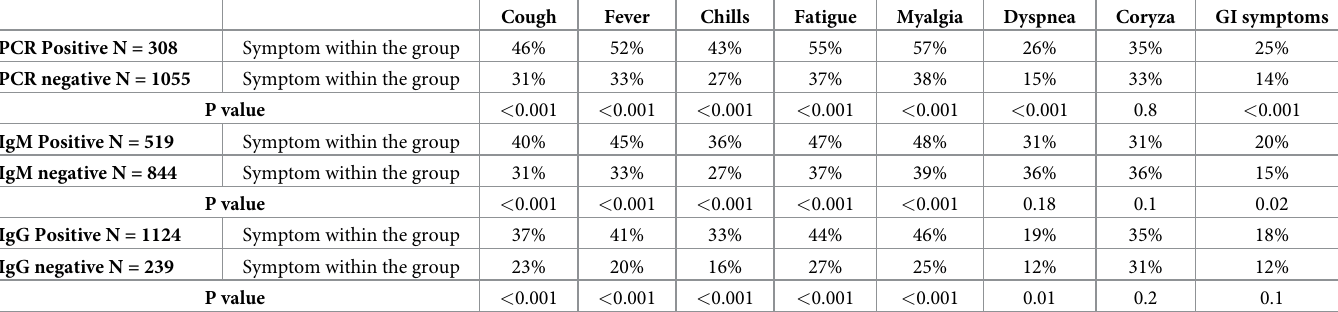
Table 2. Distribution of symptoms within groups with positive and negative PCR and